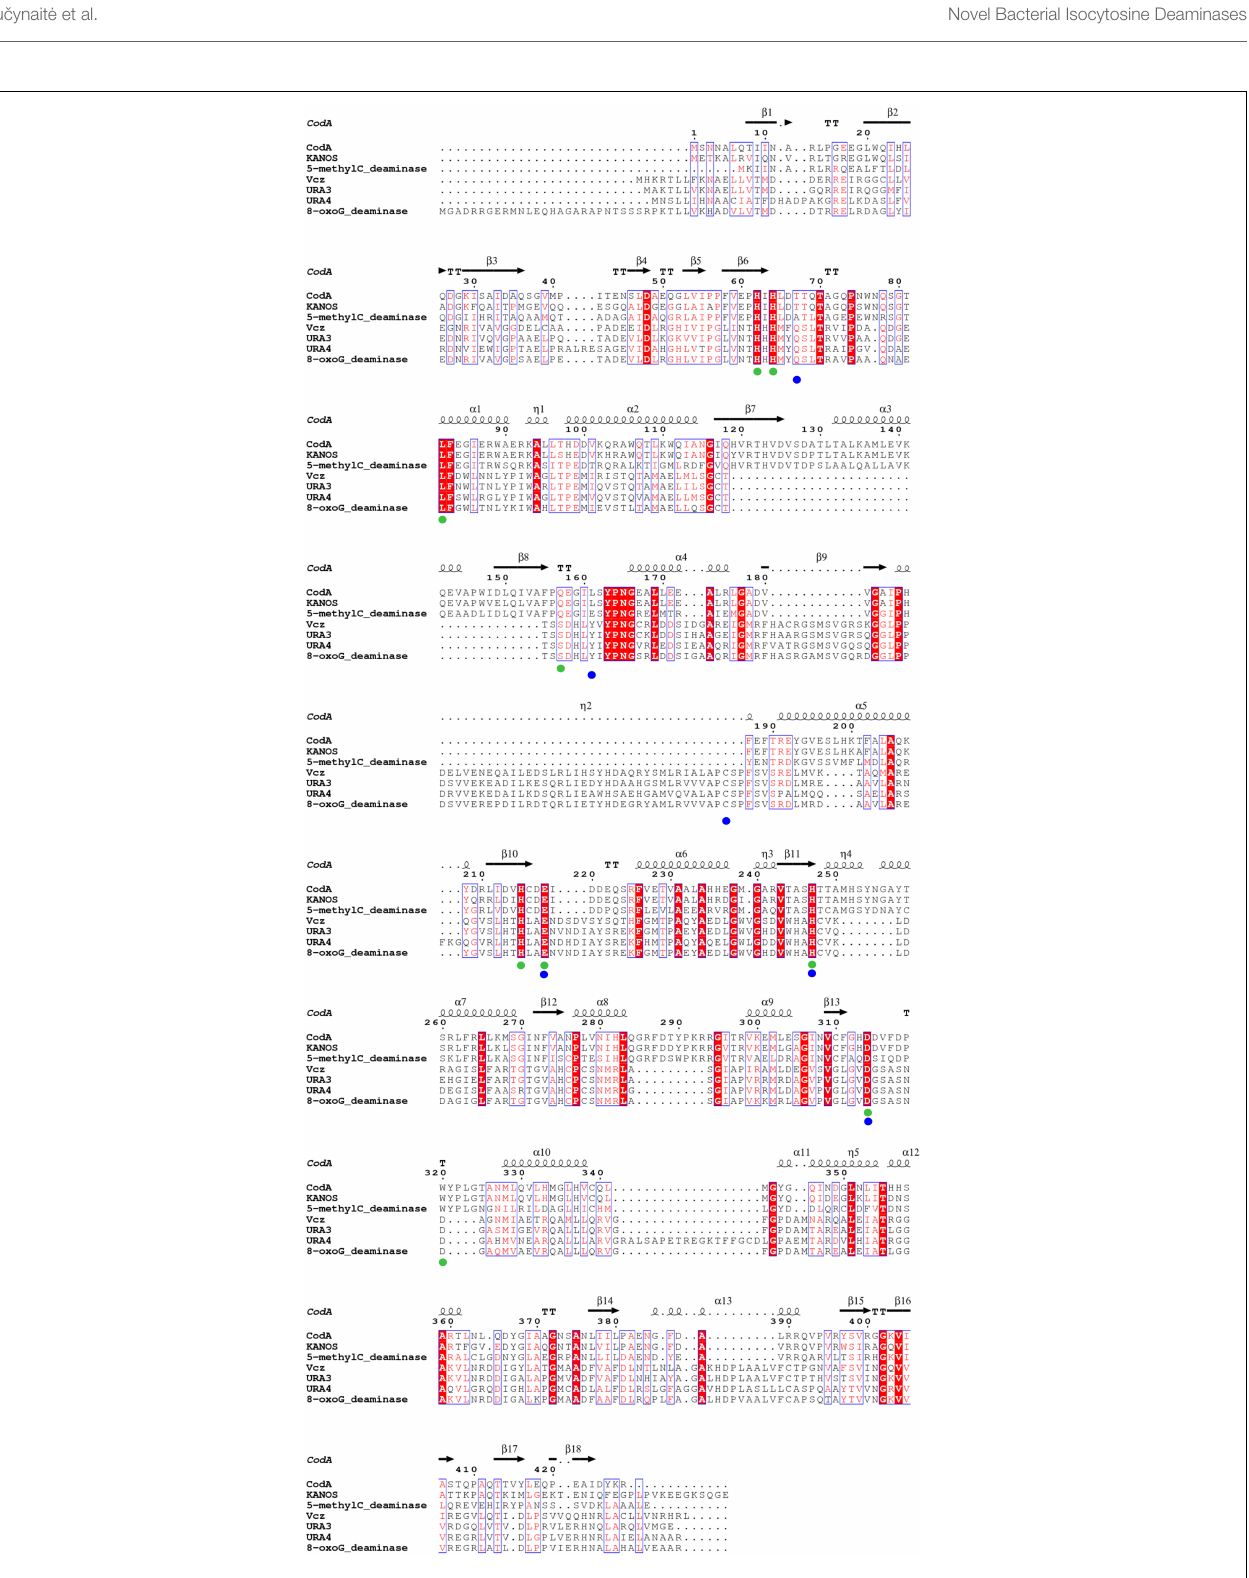
Frontiers in Microbiology |